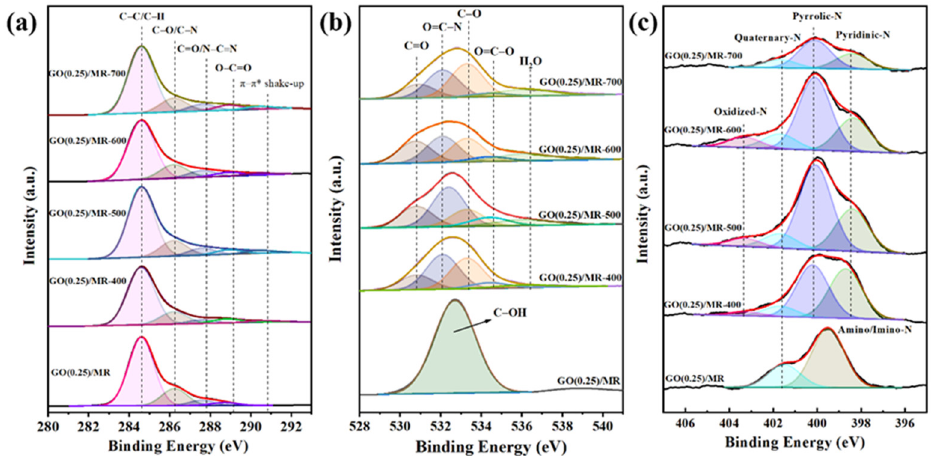
Figure 5. High resolution ( a ) C 1s, ( b ) O 1s and ( c ) N 1s XPS spectra of GO(0.25)/MR and GO(0.25)/MR-derived nitrogen-rich porous carbon materials obtained at different activation temperature.